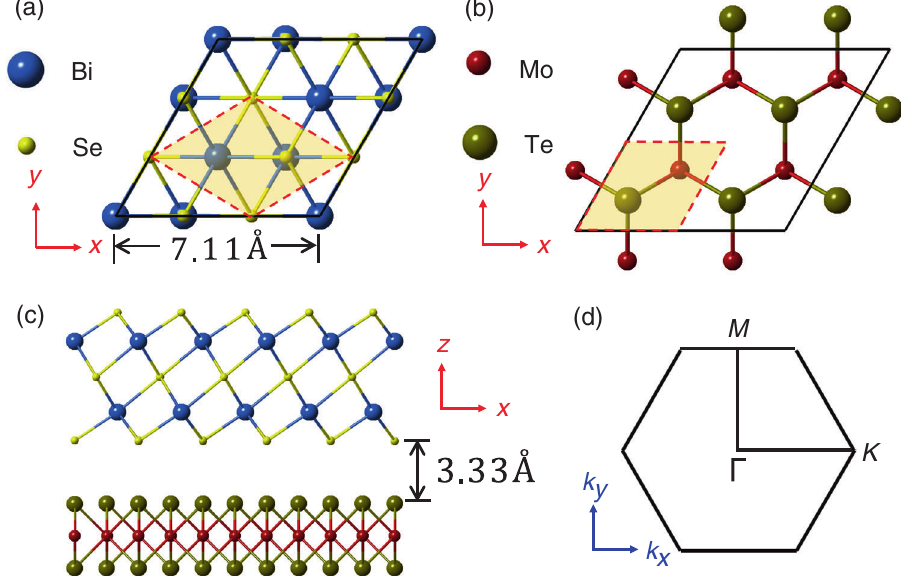
Fig. 1 The optimized lattice of the 1QL-Bi 2 Se 3 /1TL-MoTe 2 heterostructure. a Top view of the Bi 2 Se 3 part. b Top view of the MoTe 2 part. c Side view of the whole system. The supercell used in the calculations is denoted in a and b by the black solid line , in which the Bi ffiffiffi p ffiffiffi p ð ´ Þ R 30°/MoTe 3 3 2 -(2 × 2) system is incorporated. The shaded regions in cell. The corresponding Brillouin zone is shown in ( d